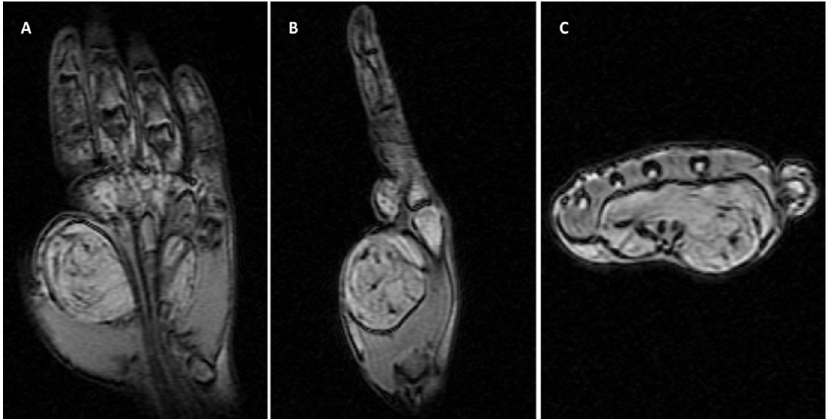
Figure 4. MRI of a giant midpalmar lipoma: clearly shaped lesion with fine homogeneous capsule, with predominantly lipomatosis signal and fine septa irregularly distributed inside the tumor with discrete gadolinophilia at septa level, beneath the palmar aponeurosis, with approximate size of 80/50 mm and a thickness of 35 mm. The lesion embedded and “detached” the group of tendinous flexors from the plan of the 2 interosseous muscles; the radial and ulnar artery with present flow in a superficial subaponeurotic location is in contact with the palmar surface of the lesion; the median nerve with a homogeneous hyposignal is structurally normal; the component bones of the wrist are normally configured, with homogeneous structure, regular bone contour, and cortically seamless; and the thenar and hypothenar muscle plans are compressed by injury ( A – C ). Complete lipoma excision was performed in all cases, these being well-encapsulated (Figure 5).